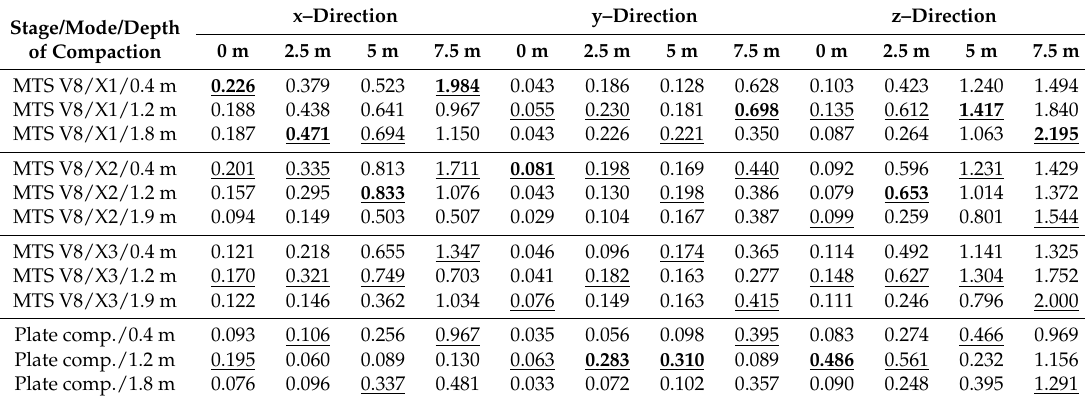
Table 3. Summary of PPAs—stage II (source of vibration Ls = 10 m), m/s 2 .